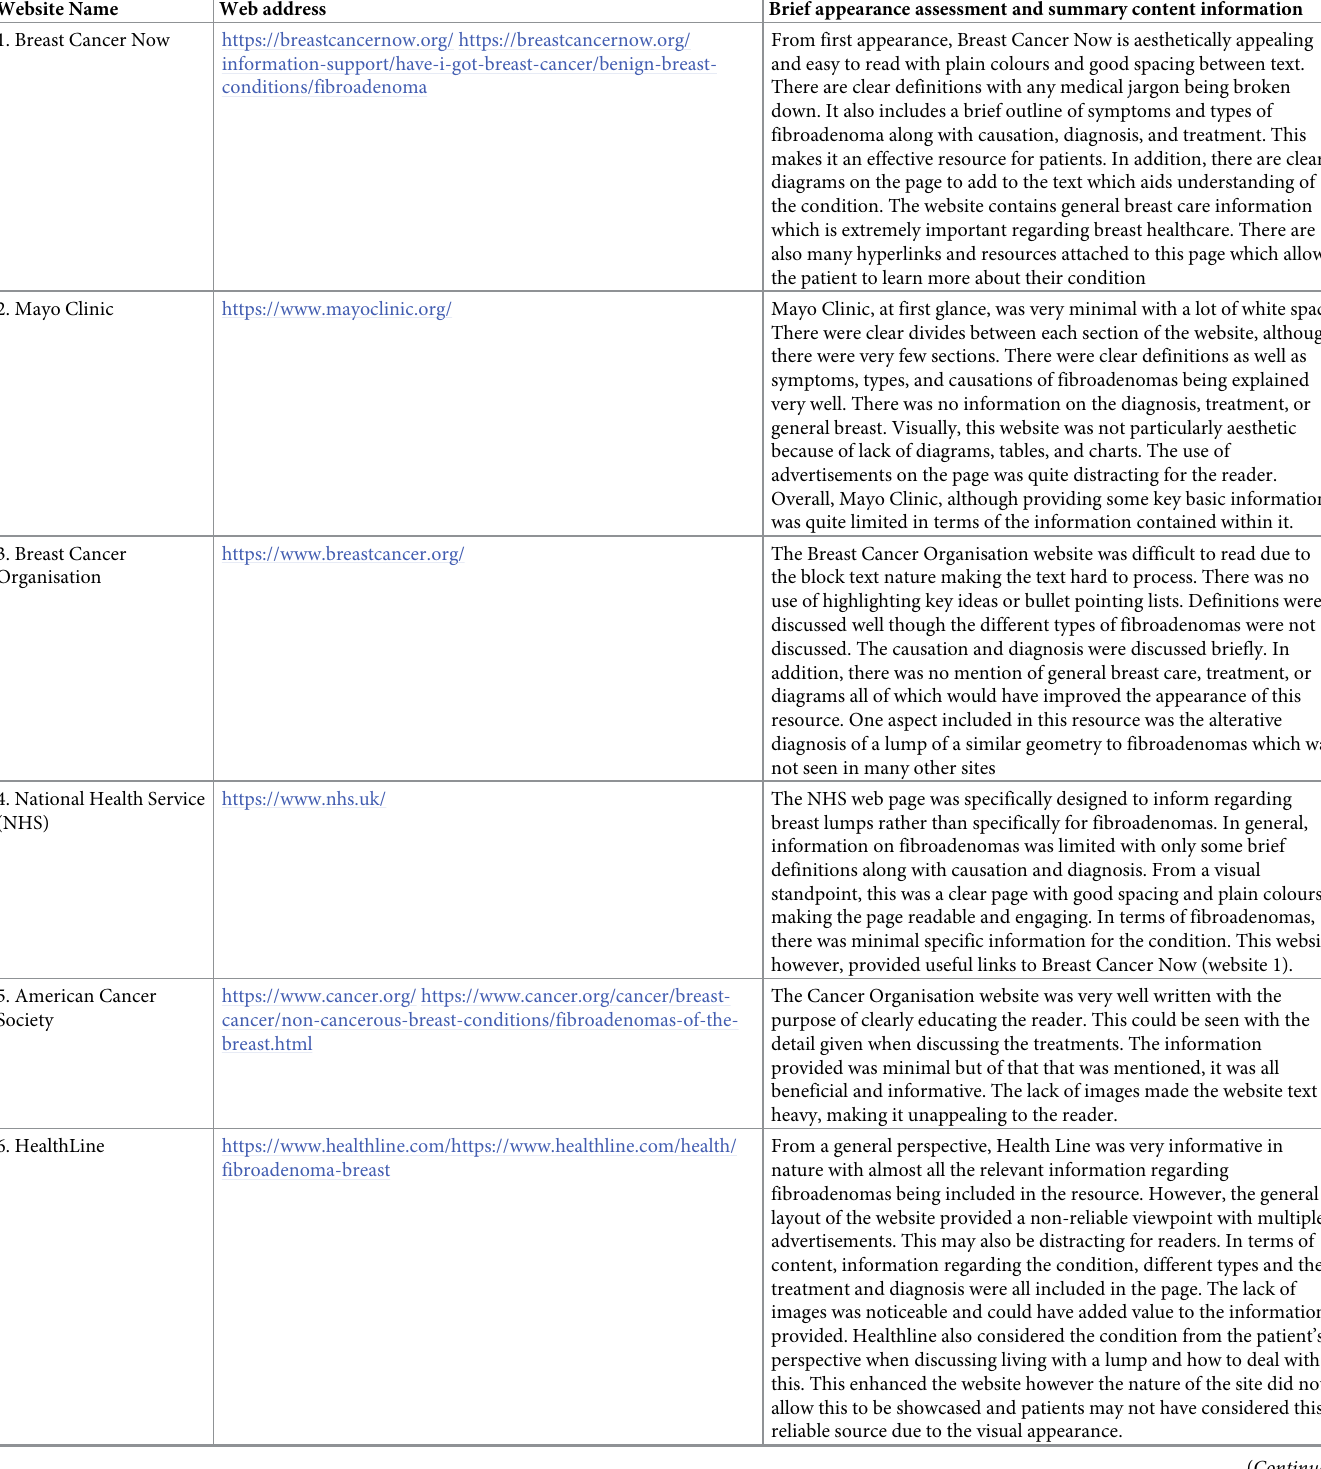
Table 3. Details of websites identified utilising Google TM Bing TM and Yahoo TM search